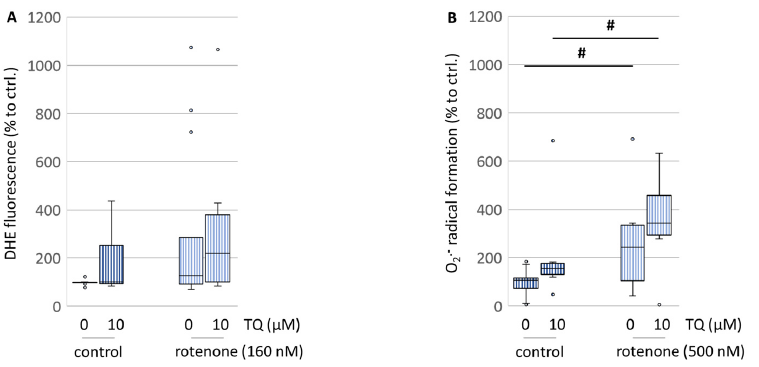
Figure 6. Effects of TQ on ROS formation detected by DHE fluorescence (48 h treatment) ( A ) and EPR spectroscopy (immediately after exposer) ( B ) in neuroblastoma cell line in the absence and presence of rotenone. The untreated control groups (0 µM TQ, 0 nM rotenone) were set to 100%. The data represent four ( A ) or eight ( B ) independent experiments. Statistical significance was determined using the Mann–Whitney (U) test (# p < 0.05).